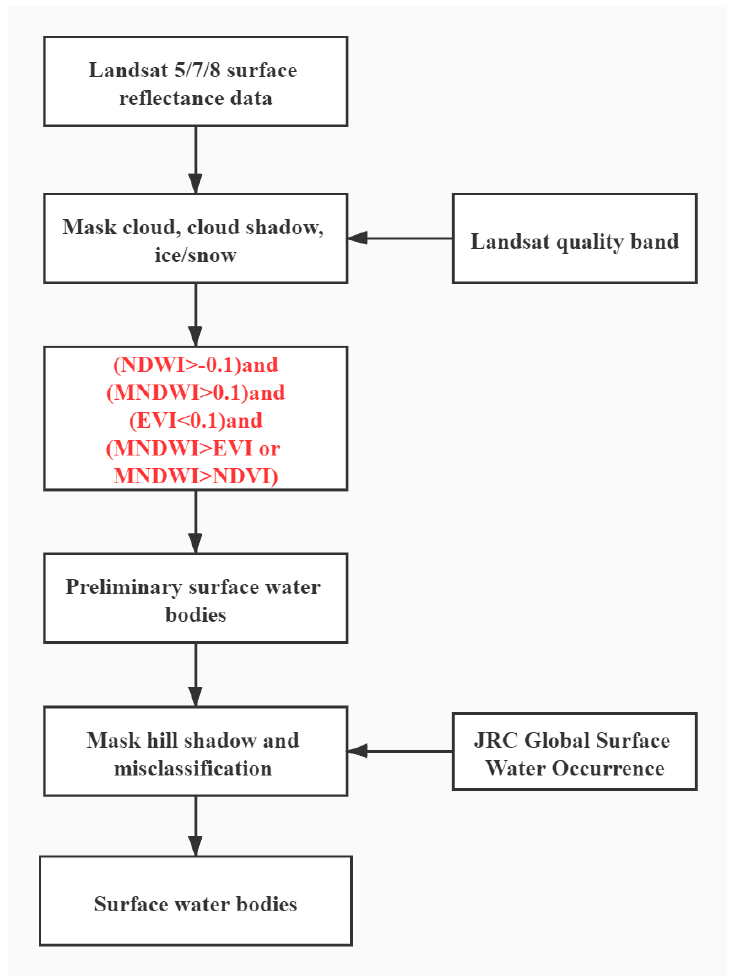
Figure 4. The flowchart of the extraction of open-surface water bodies in the TRB.